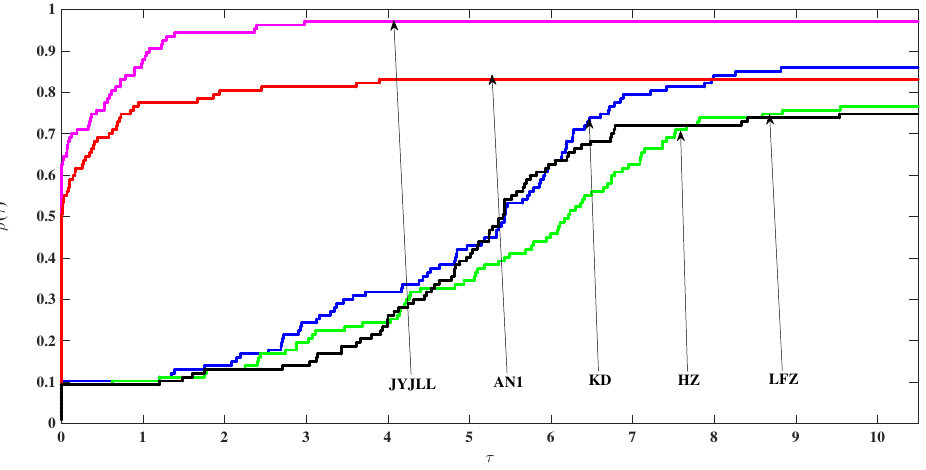
Figure 2. Performance profiles on NF .